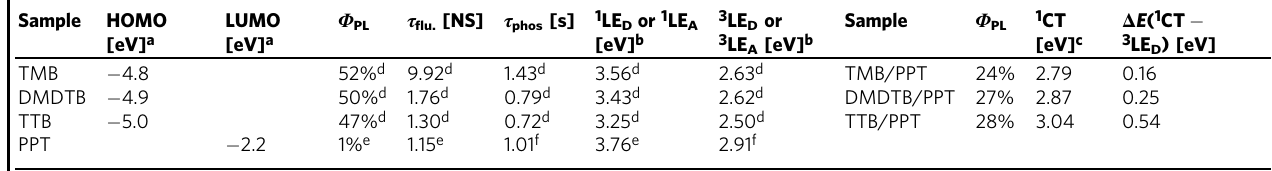
a Calculated from CV or DPV peaks b Calculated from the onset of the emission spectra c Calculated from the onset of the LPL spectra d In ZEONOR fi lm at 300K e In the neat fi lm at 300K f In the neat fi lm at